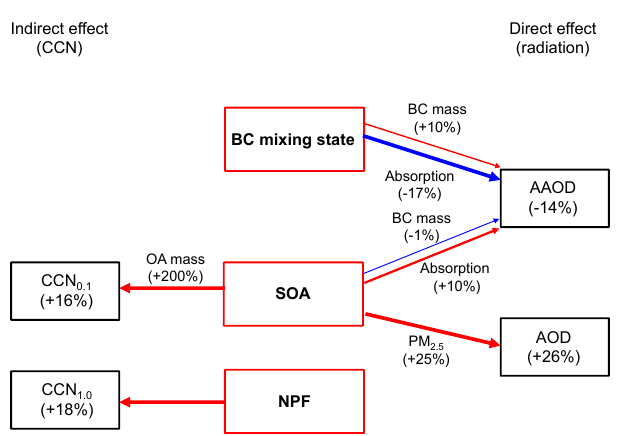
Figure 10. Summary of the sensitivity of the mass and number con- centrations and optical and radiative parameters of aerosols to NPF, BC aging, and SOA. The red (blue) lines indicate positive (negative) impacts on individual aerosol parameters (black boxes). The impact of NPF is calculated from the difference between the M01_N and M01 simulations. The impact of SOA is calculated from the dif- ference between the M10_SN and M10_N simulations. The impact of BC aging is the difference in each parameter between when the BC mixing state is resolved (the M10_SN simulation) and when the average mixing state is used (all BC particles are assumed to be in- ternally mixed) (the M01_SN simulation). The change in BC mass concentrations is due to the change in BC hygroscopicity (mixing state) and resulting wet removal processes. The change in absorp- tion is mainly due to the change in the lens effect. The percentages shown in black boxes are calculated from the difference between the M10_SN and M01